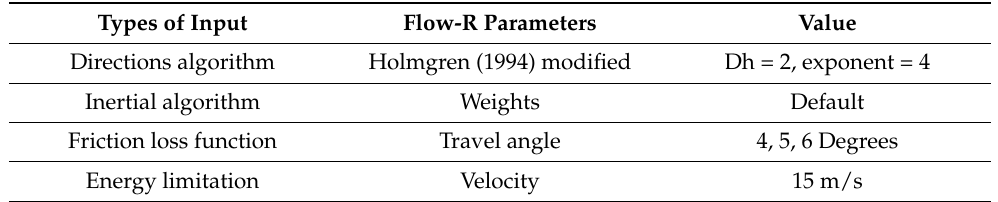
Table 3. Debris-flood parameters used in